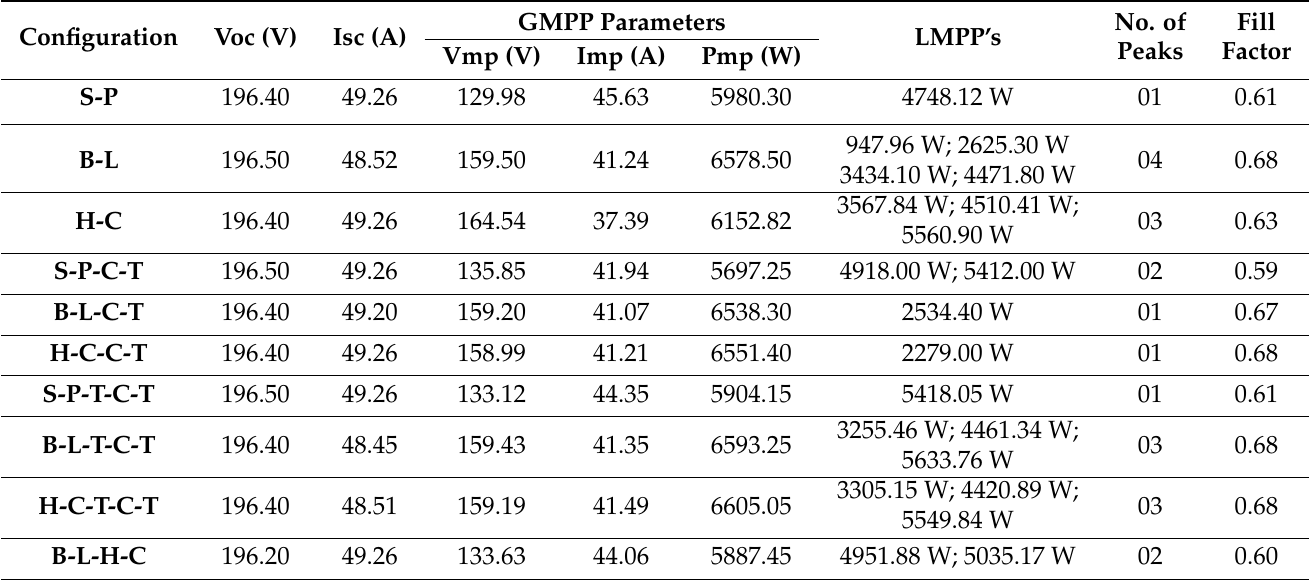
Table 4. Parameter variations of conventional and hybrid array configurations under diagonal